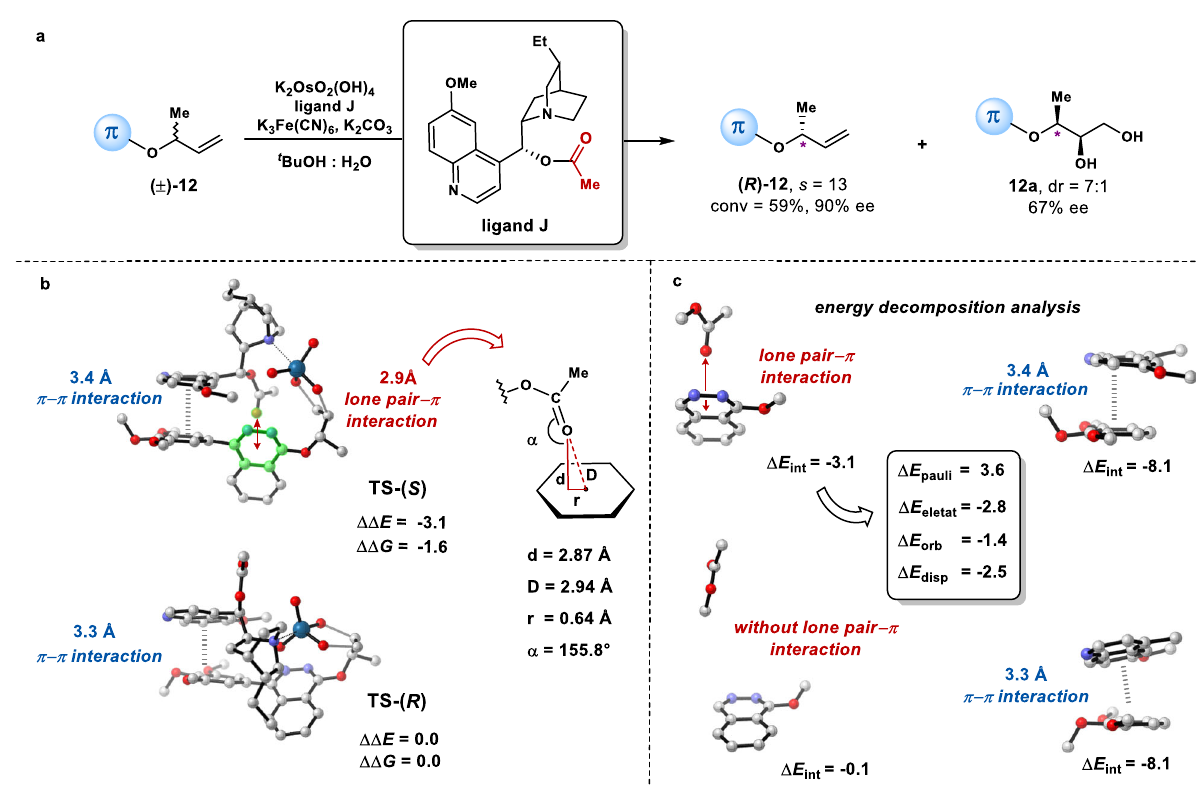
Fig. 4 Combined experimental and computational investigation on the origins of stereoselectivity for the AD-based kinetic resolution using a model system. a Experimentally observed stereoselevtivitits for both recovered ( R ) -12 and the diol product 12a from the AD-based kinetic resolution. b Representative DFT-computed transition state structures TS-( S ) and TS-( R ) for this reaction. c Energy decomposition analysis for truncated structures of TS-( S ) and TS-( R ). Relative energies are given in kcal/mol. TS: transition